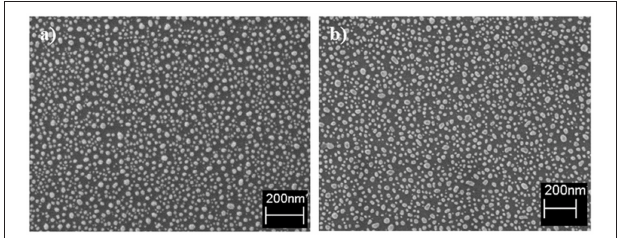
FIGURE 1 | SEM images nanomaterials. Nanocomposed of Au nanoparticles on TiO 2 flat film (A) before and (B) after a 12 days dipping in aquatic